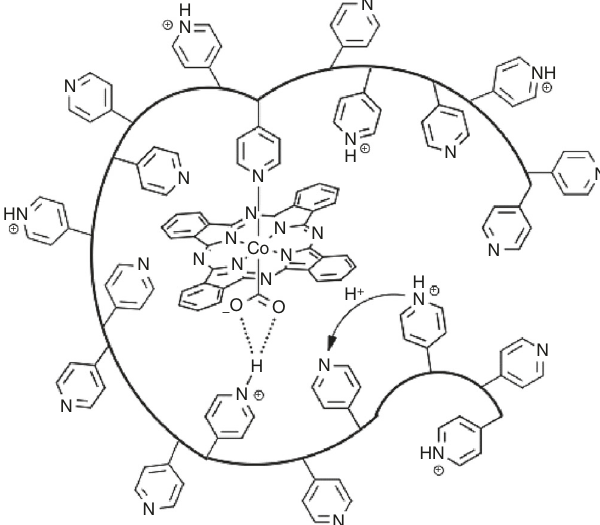
Fig. 1 An illustration of a cobalt phthalocyanine (CoPc) encapsulated within a hydrophobic poly-4-vinylpyridine (P4VP) membrane highlighting the postulated primary-, secondary-, and outer-coordination sphere effects